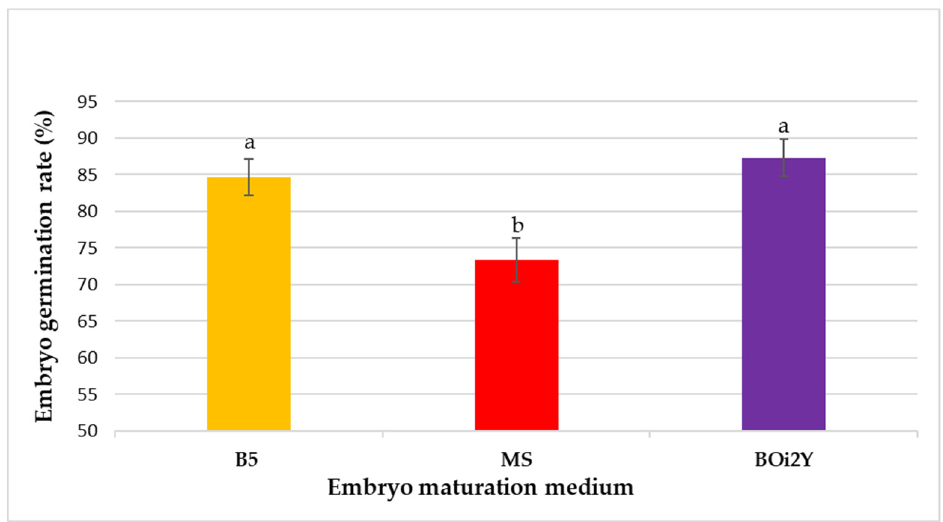
Figure 6. Embryo germination rate on the MMS medium after being transferred from a different maturation medium. Values represent mean ± SD ( n = 30) and different letters indicate a significant difference according to the Tukey Kramer HSD test at p ≤ 0.05.